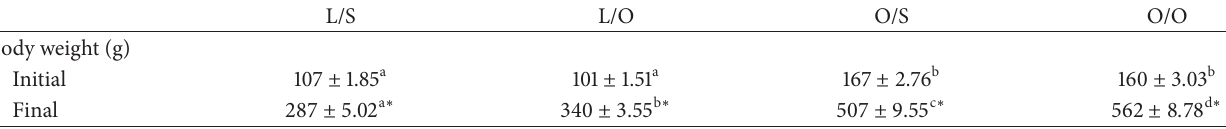
Table 1: Initial and final body weights of sham and ovariectomized lean and obese female Zucker rats. L/S L/O O/S O/O Body weight (g) Initial 107 ± 1.85 a 101 ± 1.51 a 167 ± 2.76 b 160 ± 3.03 b Final 287 ± 5.02 a ∗ 340 ± 3.55 b ∗ 507 ± 9.55 c ∗ 562 ± 8.78 d ∗ Values are expressed as mean ± SEM. Values that do not share the same superscript letters are significantly (𝑃 < 0.0001) different from each other. ∗ 𝑃 < 0.001 versus baseline. 𝑛 = 6 rats/group. L/S, lean ( 𝐿𝑒𝑝𝑟 𝑓𝑎/+ ) sham-operated; L/O, lean ( 𝐿𝑒𝑝𝑟 𝑓𝑎/+ ) ovariectomized; O/S, obese ( 𝐿𝑒𝑝𝑟 𝑓𝑎/𝑓𝑎 ) sham-operated; and O/O, obese ( 𝐿𝑒𝑝𝑟 𝑓𝑎/𝑓𝑎 ) ovariectomized. Table 2: Effects of ovariectomy and obesity on DXA bone parameters of fourth lumbar (L4) vertebrae. L/S L/O O/S O/O 𝑃 value BMA (cm 2 ) 0.43 ± 0.012 0.41 ± 0.011 0.44 ± 0.017 0.43 ± 0.014 0.586 BMC (g) 0.097 ± 0.004 ab 0.082 ± 0.003 a 0.102 ± 0.005 b 0.089 ± 0.005 ab 0.030 BMD (g/cm 2 ) 0.226 ± 0.004 a 0.200 ± 0.002 b 0.231 ± 0.004 a 0.205 ± 0.007 b < 0.001 Values are mean ± SEM; 𝑛 = 10 rats/group. Values that do not share the same superscript letters are significantly (𝑃 < 0.05) different from each other. 𝑛 = 6 rats/group. L/S, lean ( 𝐿𝑒𝑝𝑟 𝑓𝑎/+ ) sham-operated; L/O, lean ( 𝐿𝑒𝑝𝑟 𝑓𝑎/+ ) ovariectomized; O/S, obese ( 𝐿𝑒𝑝𝑟 𝑓𝑎/𝑓𝑎 ) sham-operated; and O/O, obese ( 𝐿𝑒𝑝𝑟 𝑓𝑎/𝑓𝑎 )